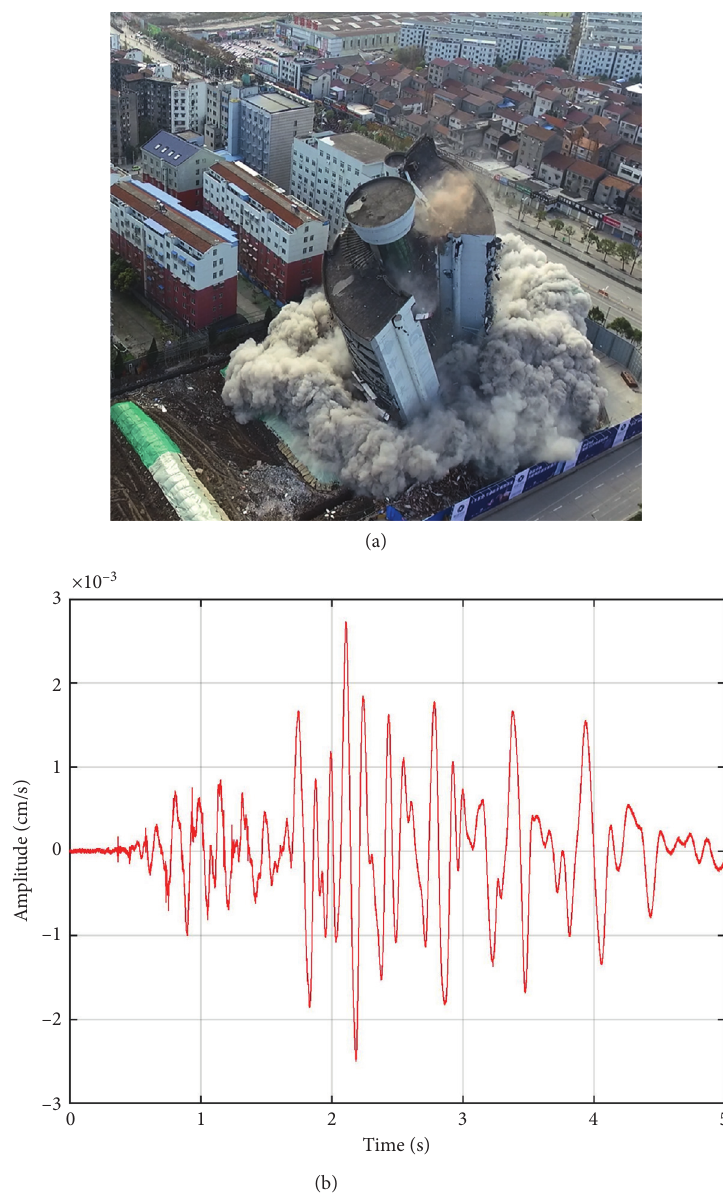
Figure 4: Demolition collapse vibration. (a) Blasting project of investment Plaza building in Jingzhou, Hubei Province. (b) Vibration